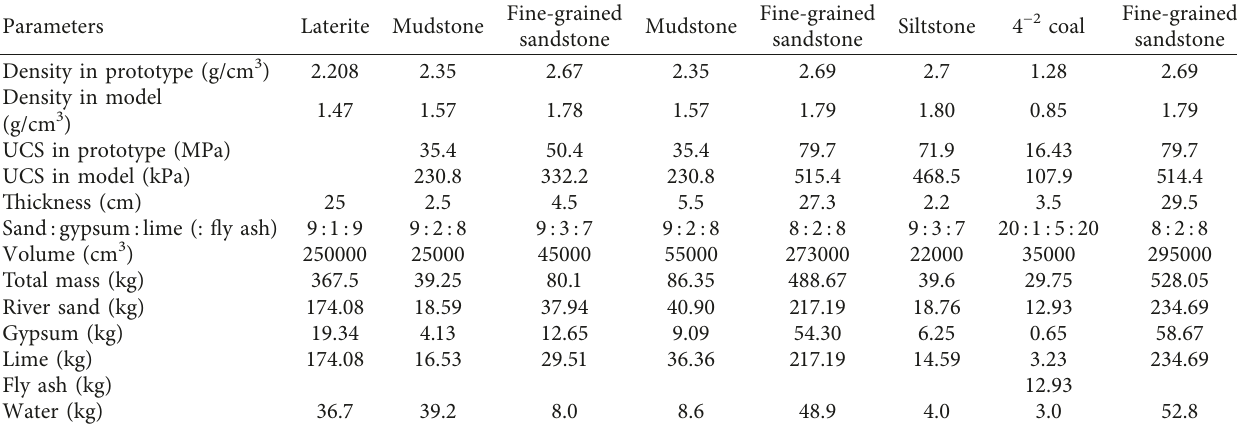
Table 3: Proportion schemes for similar materials of simulated rock